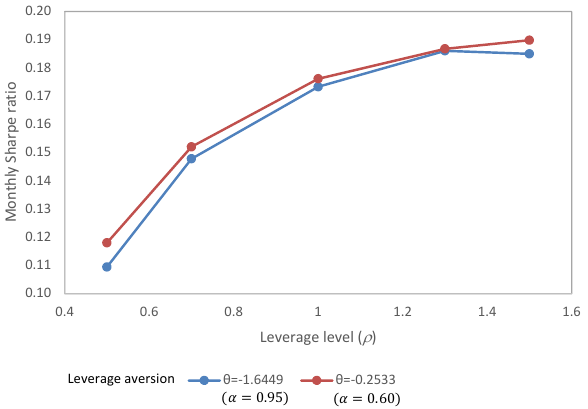
Figure 5. Effect of leverage ratio on MV frontiers under market impact ( θ = − 1.6449).